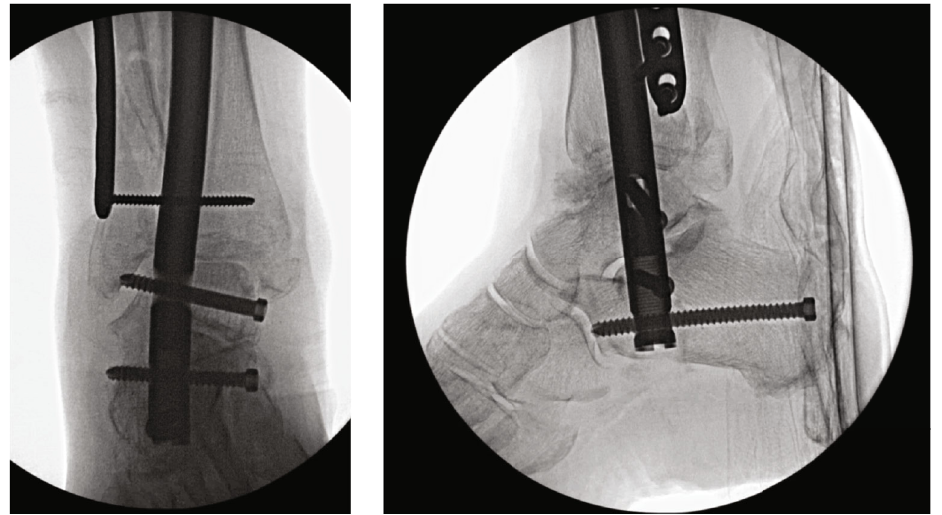
Figure 6: Final implant